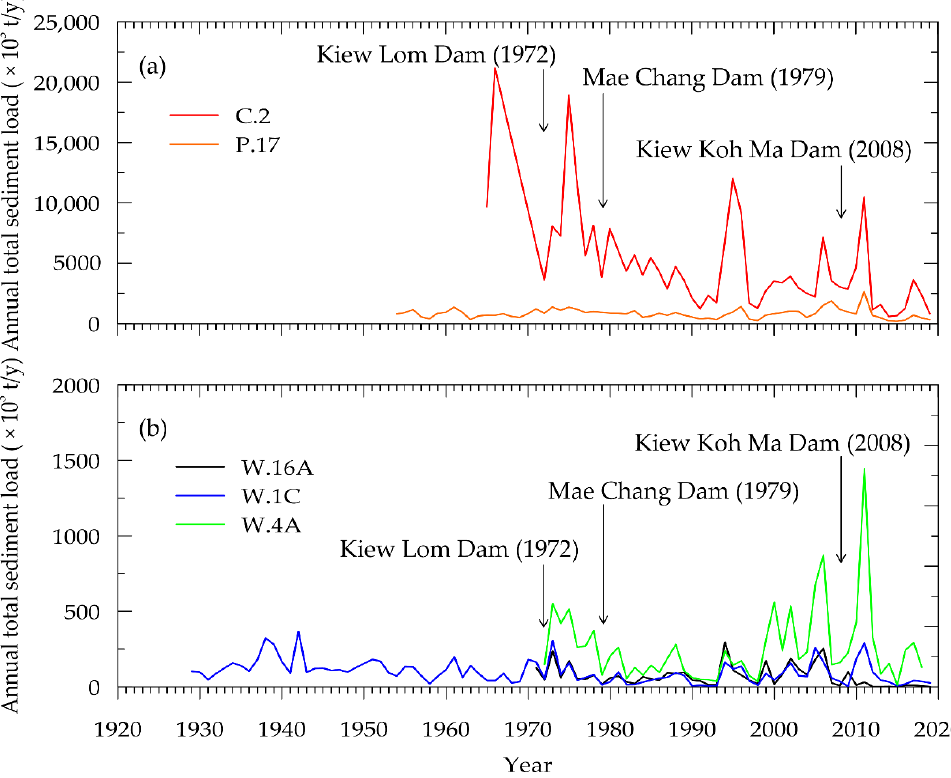
Figure 8. Time series of total sediment load at the RID hydrological stations: ( a ) P.17 and C.2; ( b ) W.16A, W.1C, and